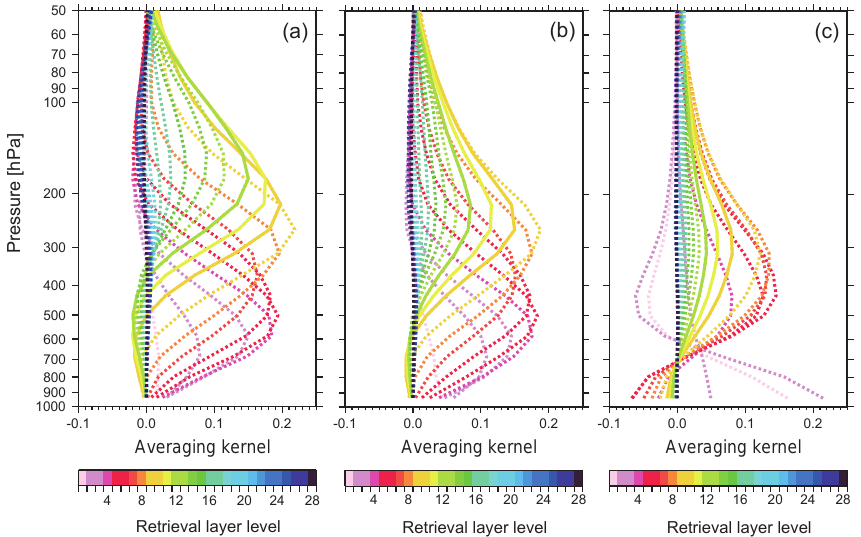
Figure 1. Averaging kernel functions of GOSAT/TANSO-FTS TIR V1 CO 2 retrieval in the 28 retrieval grid layers shown in Table 1: (a) low latitudes in summer, (b) middle latitudes in spring, and (c) high latitudes in winter. Solid orange, yellow, and green lines indicate averaging kernel functions of each of the three layer levels: 9, 10, and 11,